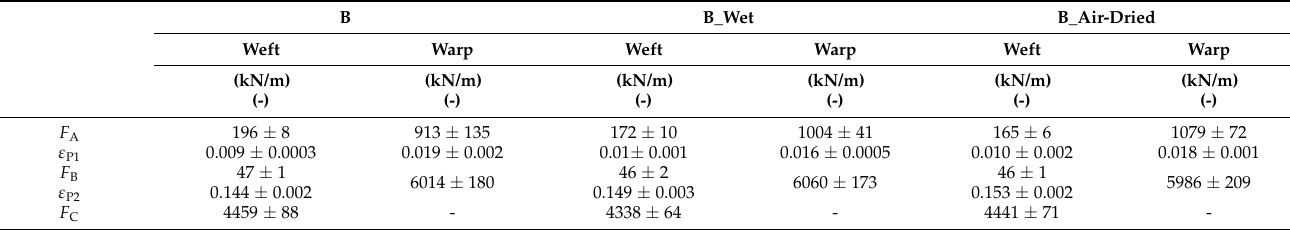
Table A8. Longitudinal stiffnesses of B type